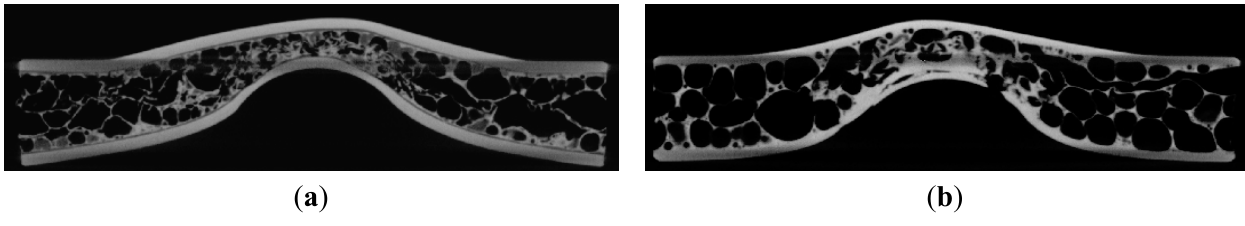
Figure 12. CT images of the AFS panels (( a ) Alulight ; ( b ) Schunk ) after impact ( v = 4